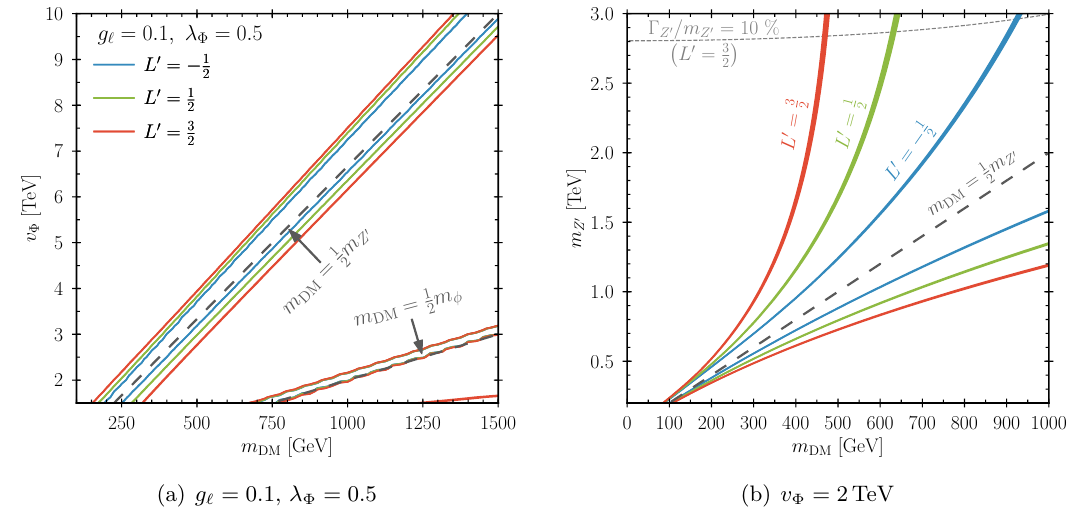
Figure 3 . Parameter regions reproducing the DM relic density h 2 (cid:10) DM = 0 : 1198 (cid:6) 0 : 0015 measured by Planck [43] within two standard deviations for di(cid:11)erent values of L 0 , (cid:12)xing the gauge coupling (left) or scalar VEV (right). The gray, dashed lines in the right plot indicate the parameters for which the Z 0 width exceeds 10 % of its